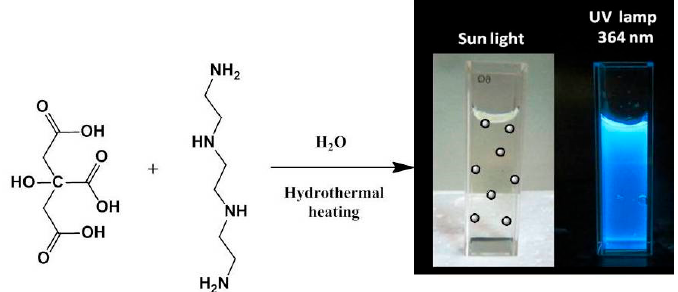
Figure 1. Synthetic procedure of CD CA-TETA . Photos with dispersion of purified CDs in water under sunlight and UV lamp.